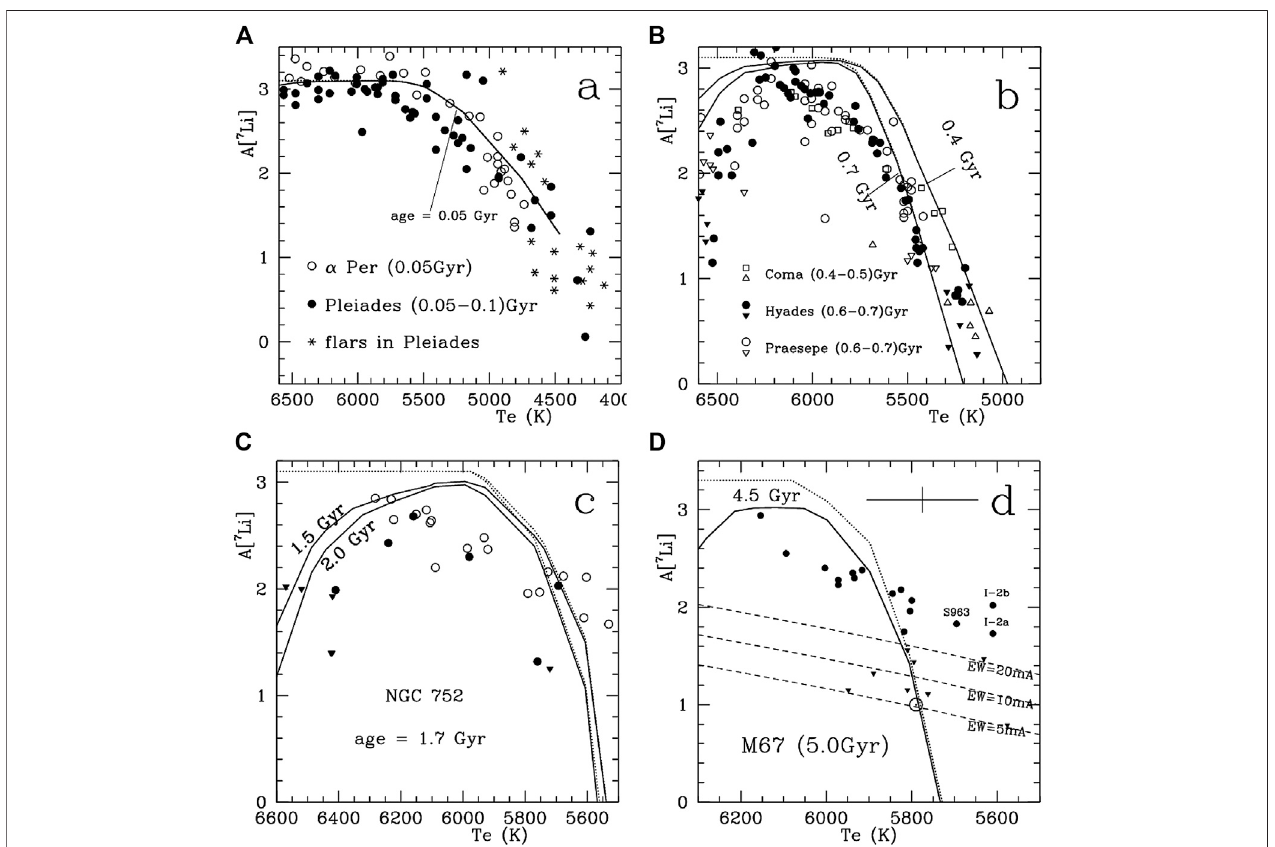
FIGURE11| Lithium abundanceasafunctionoflog T e forthememberstarsinGalacticopenclusters: (A) Pleiades ( fi lledcirclesandstars)and α Per(opencircles), (B) Hyades ( fi lled circles and inverse triangles), Praesepe (open circles and inverse triangles) and Coma Berenices (open squares and triangles), (C) NGC752, and (D) M67,where ⊙ isthepositionoftheSun.Thesolidanddottedlinesare,respectively,thetheoreticalisochroneswithandwithoutgravitationalsettlingfortheagesmarked.